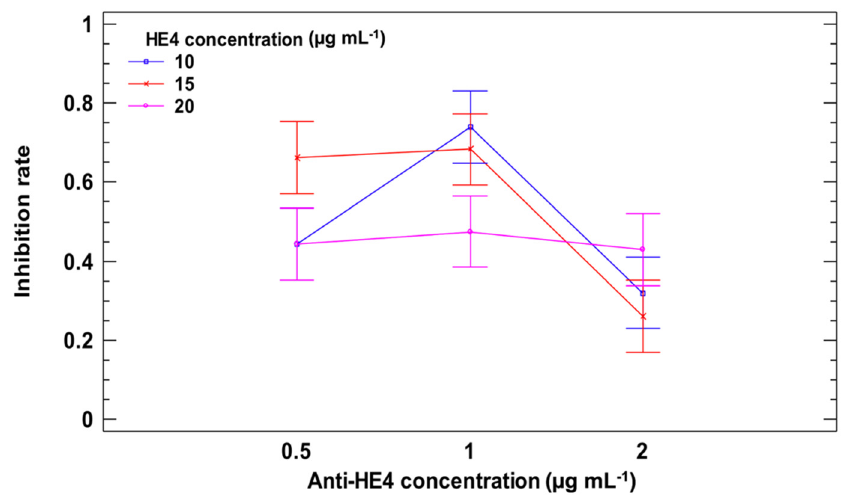
Figure 1. Interaction plot from two-way ANOVA. Factors: concentration of HE4 for functionalization and concentration of anti-HE4 antibody; Response: signal inhibition.